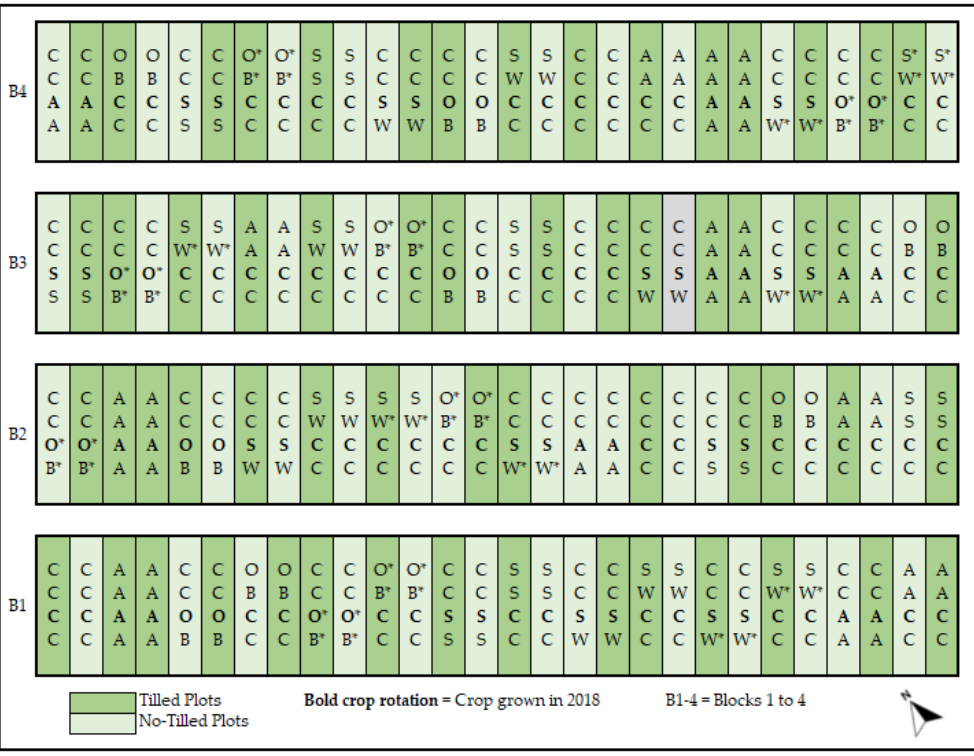
Figure 2. Field study layout and location of the plots with their respective descriptive crop rotation type cited in Table 1. Soil samples were collected from the center of each plot. For the purpose of illustration, the scale was not respected. C—corn ( Zea mays ); S—soybean ( Glycine max ); W—winter wheat ( Triticum aestivum ); B—barley ( Hordeum vulgare L.); O—oats ( Avena sativa L.); A—alfalfa ( Medicago sativa L.); *—red clover ( Trifolium pretense L. ) cover crop after cereal harvest.